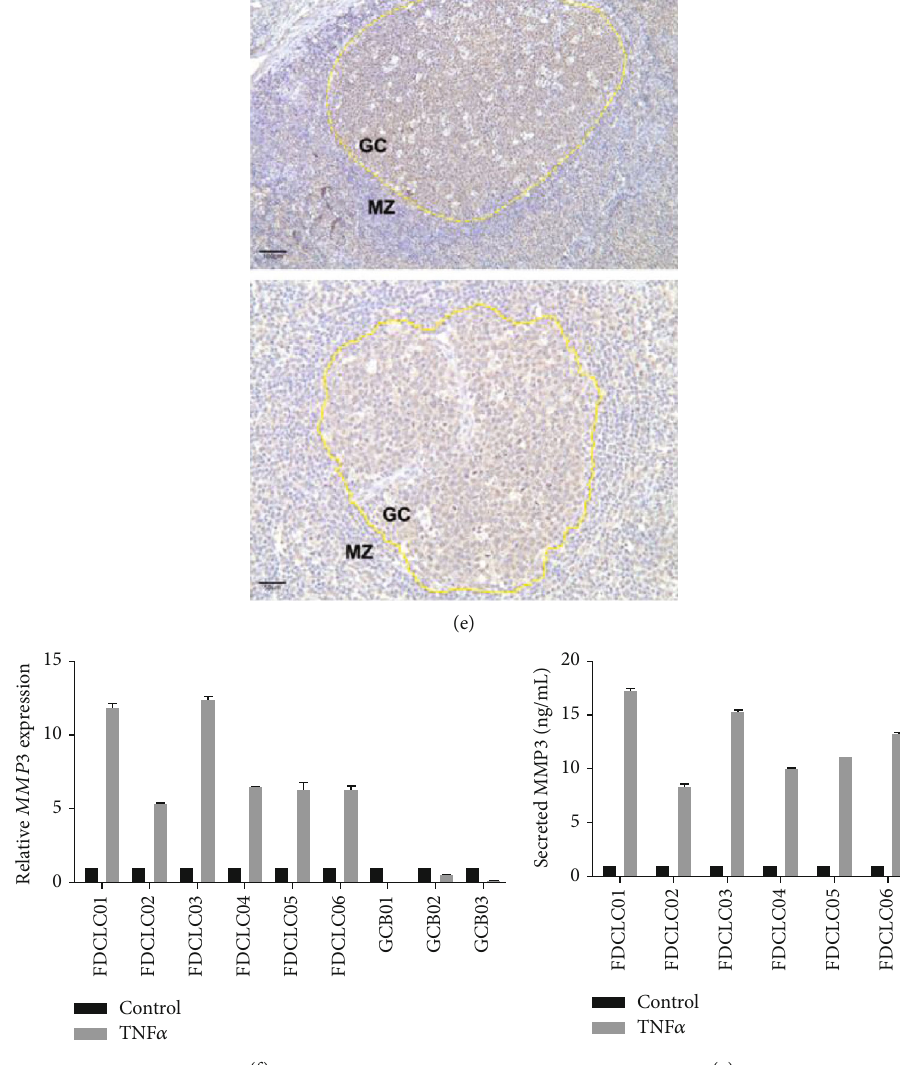
Figure 1: Human follicular dendritic cell-like cells (FDCLCs) in germinal centers (GCs) express MMP3. (a) Microarray gene expression pro fi ling analysis comparing nontreated control and TNF α -treated FDCLCs. (b) Luminex protein secretion pro fi les of the same samples. (c) Microarray and Luminex results for TNF α -stimulated FDCLCs. FDCLCs were isolated from resected human tonsil tissues (i.e., from routine tonsillectomies). The isolated cells were treated with 20ng/mL of TNF α for 18h, and mRNAs and culture supernatants were harvested. Microarray results revealed that TNF α exposure increased the expression of MMP1 , MMP12 , and MMP3 , whereas Luminex results indicated that TNF α induced the secretion of both MMP3 and MMP9. (d) Schematic depiction of the microarray and Luminex results. Both the mRNA expression and protein secretion of MMP3 were increased. (e) Immunohistochemical staining of MMP3 in human tonsillar sections. Brown color shows MMP3 expression, and blue color indicates stained nucleus (hematoxylin). The boundary between the germinal center (GC) and the marginal zone (MZ) is indicated by a yellow dotted line. (f) MMP3 mRNA expression in human FDCLCs and GC-B cells. mRNAs were isolated from the TNF α -treated cells, and quantitative PCR was then performed. Mmp3 was found to be markedly induced by TNF α in all of the examined primary FDCLCs, but not in the GC-B cells. (g) MMP3 secretion of FDCLCs. FDCLCs were treated with 20 ng/mL of TNF α for 48 h. MMP3 in the culture supernatant was quanti fi ed by ELISA. MMP3 secretion from FDCLCs was markedly induced by exposure of these cells to TNF α